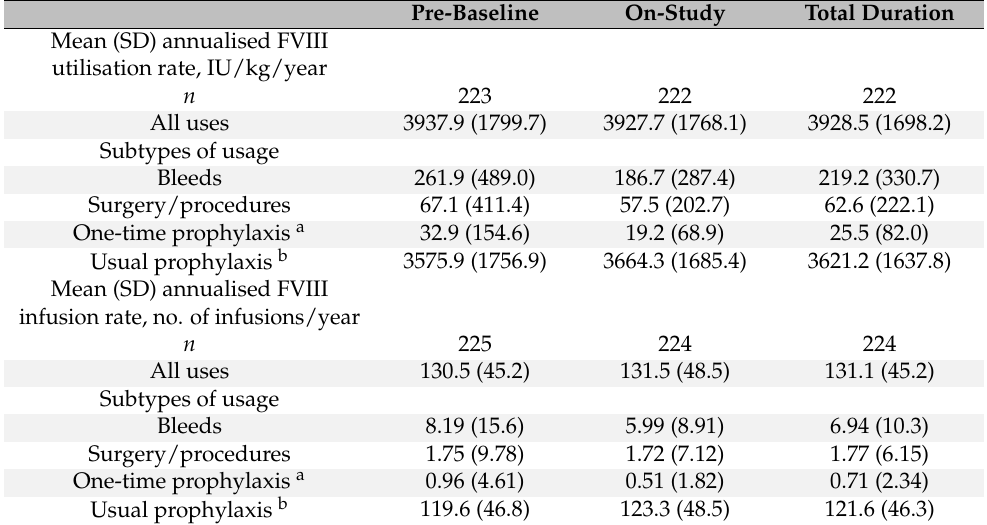
Table 3. Pre-baseline and on-study annualised FVIII utilisation and infusion rates of the 6-Month Analysis